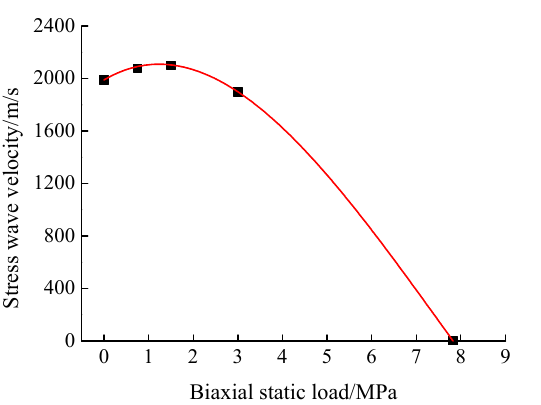
Figure 4. Relationship between the stress wave velocity and the static load of the intact rock.